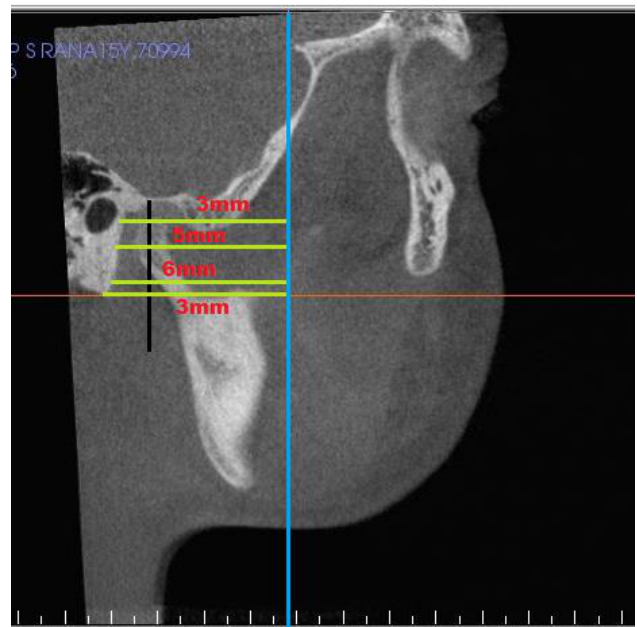
Figure 6. Posterior wall of glenoid fossa measurements: PF1 — At distance 3 mm from superior point of fossa; PF2 — At distance 5 mm from PF1; PF3 — At distance 6 mm from PF2; PF4 — At distance 3 mm from PF3.